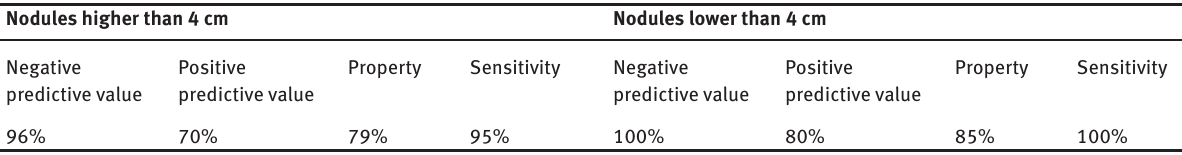
Table 2: Evaluation of diagnostic tests in nodules lower than 4 cm Nodules higher than 4